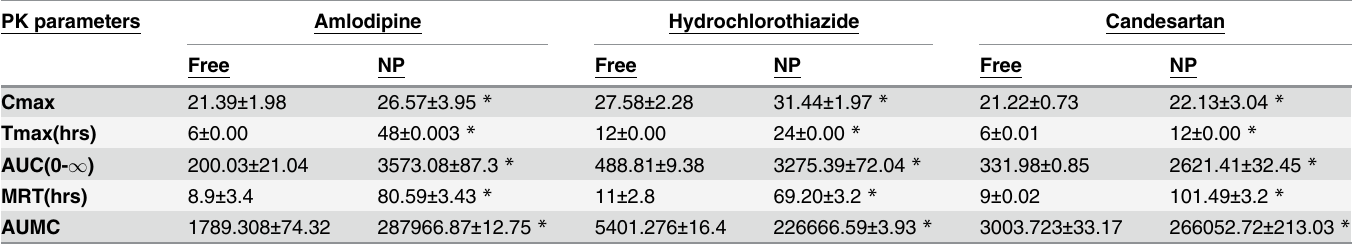
Table 2. Pharmacokinetic parameters of the individual components of the HTN NanoFDC in free and nanoparticles. PK parameters